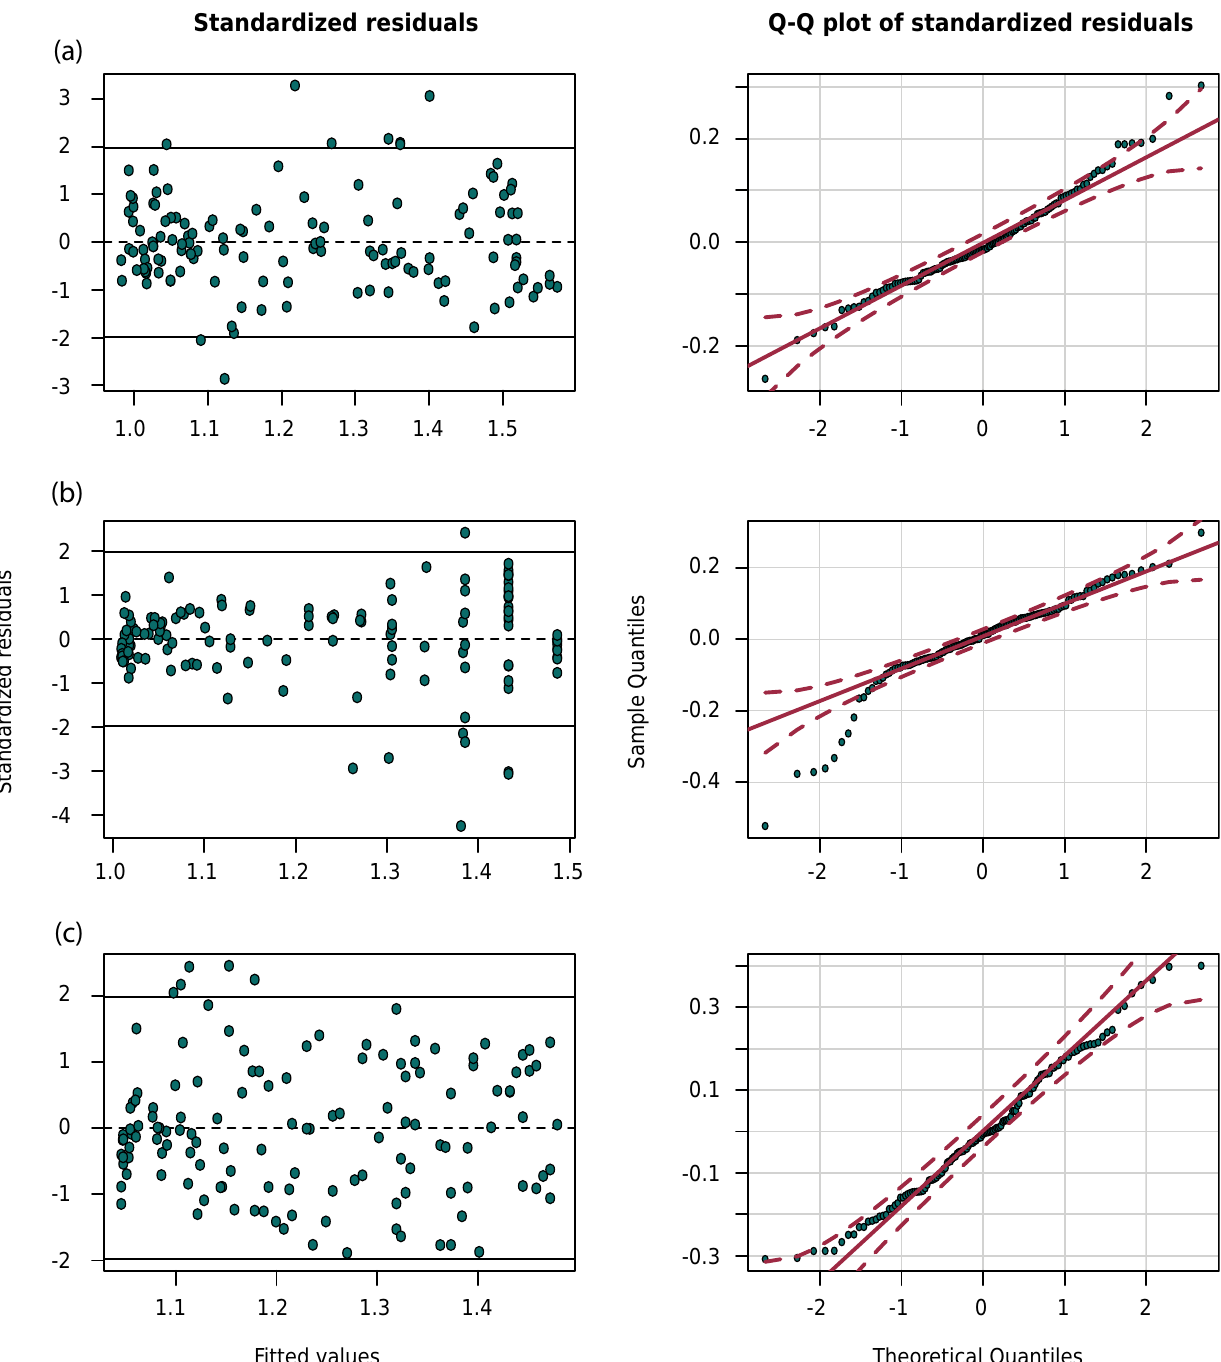
Figure 5. Fitted values vs. Standardized Residuals Plot (left panels) and the standardized residuals in a normal Q-Q Plot (right panels) to (a) PTF1, (b) PTF2, and (c)